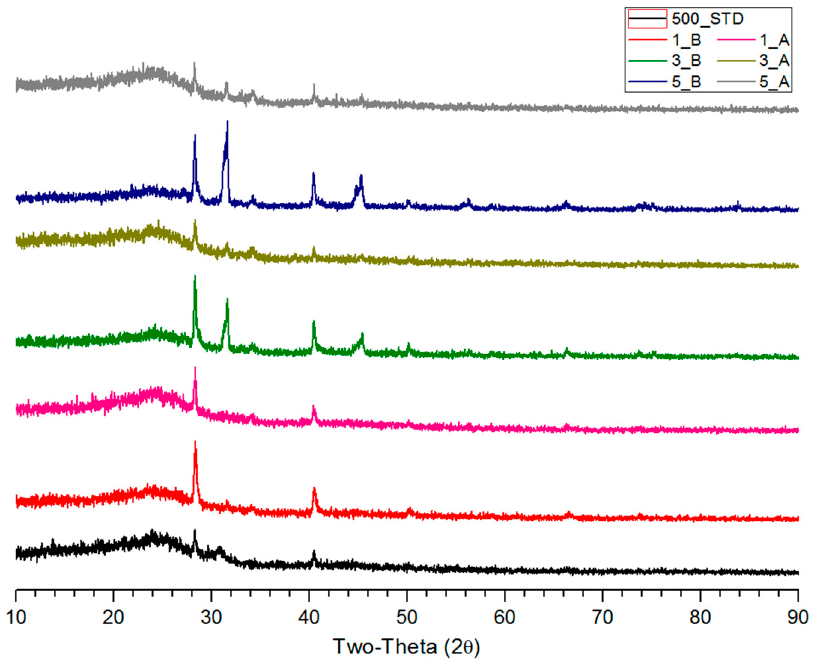
Figure 4. The XRD result of biochar pyrolyzed at 500 °C before and after flushing.